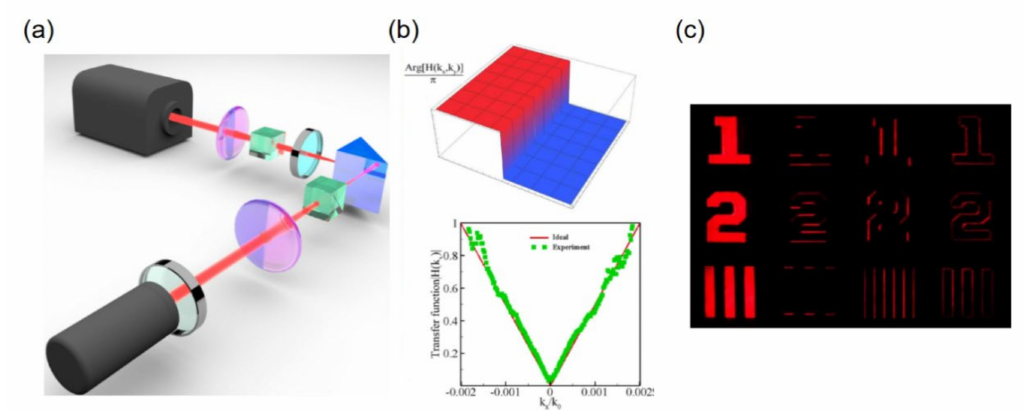
Figure 11. ( a ) The experimental setup for measurement of the spatial spectral transfer function of the first order spatial differentiator based on GH effect; ( b ) top: the phase distribution for the spatial spectral transfer function. Bottom: the comparison of theoretical and experimental results for the spatial spectral transfer function for k x = 0; ( c ) output image of edge detection with different rotating angles. Adapted with permission from [149], AIP Publishing,